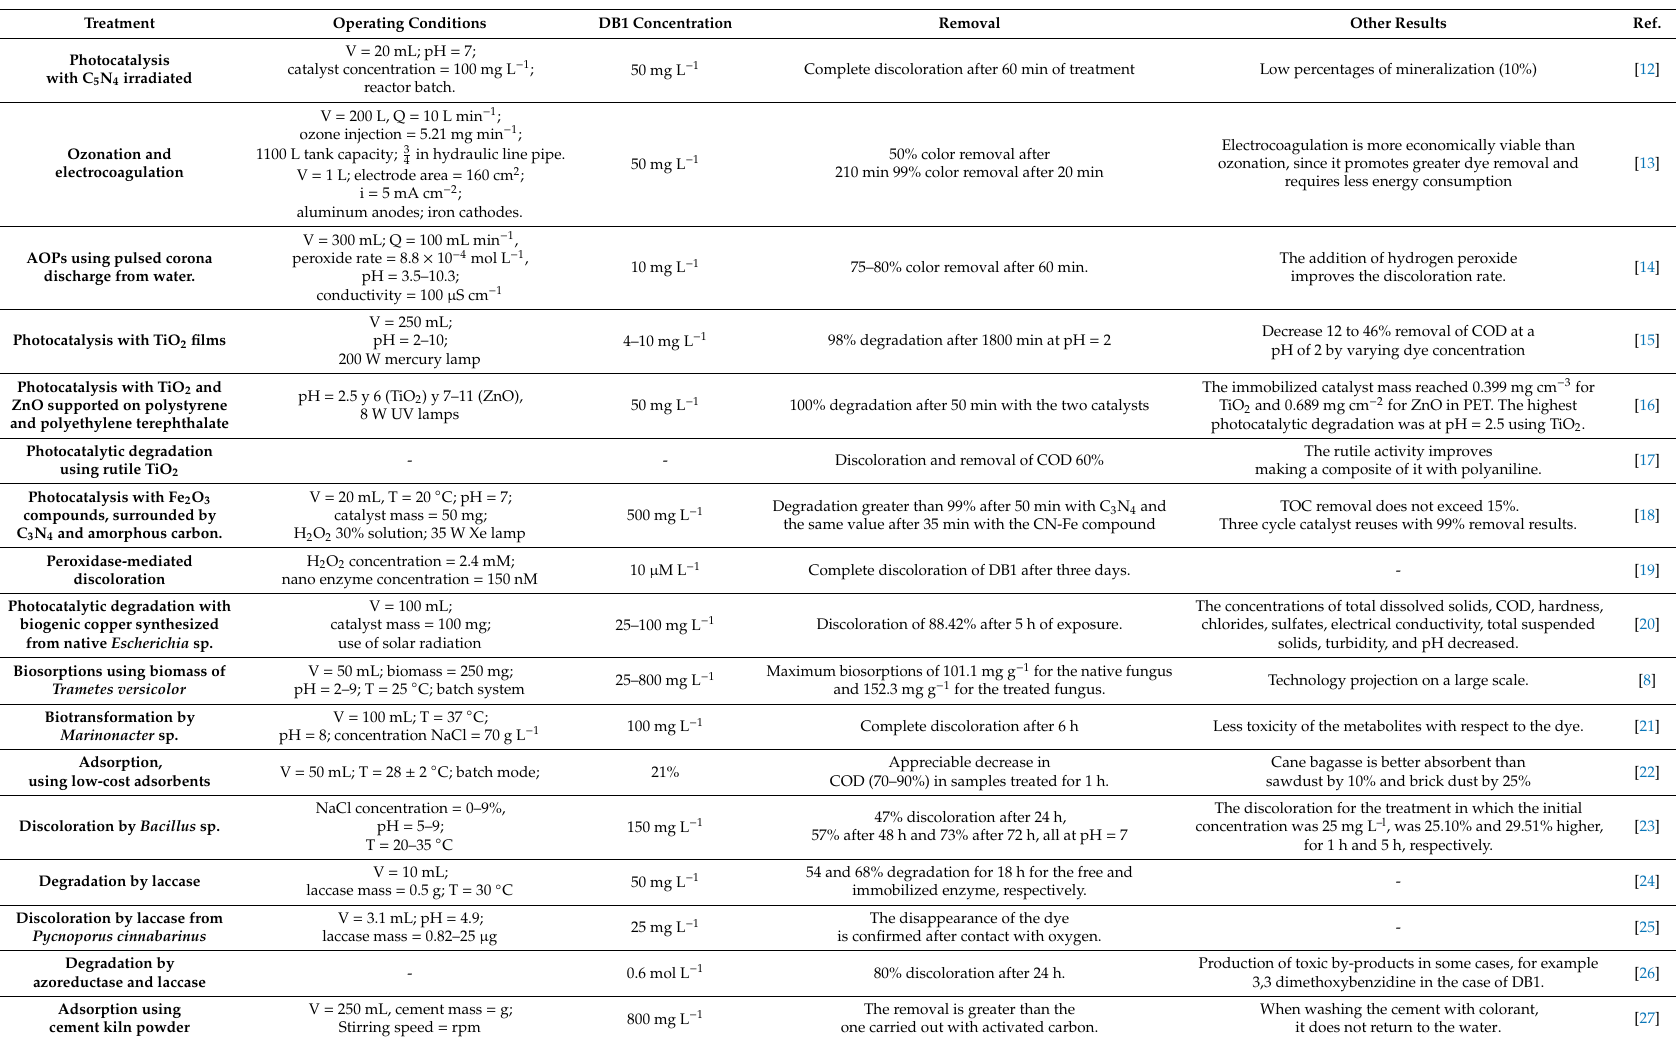
Table 1. DB1 degradation using Advanced Oxidation Processes (AOPs) and other